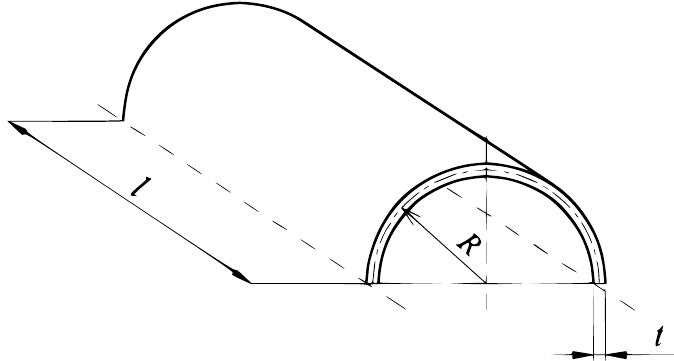
Figure 7. A half of the membrane-dominated piezoelectric shell